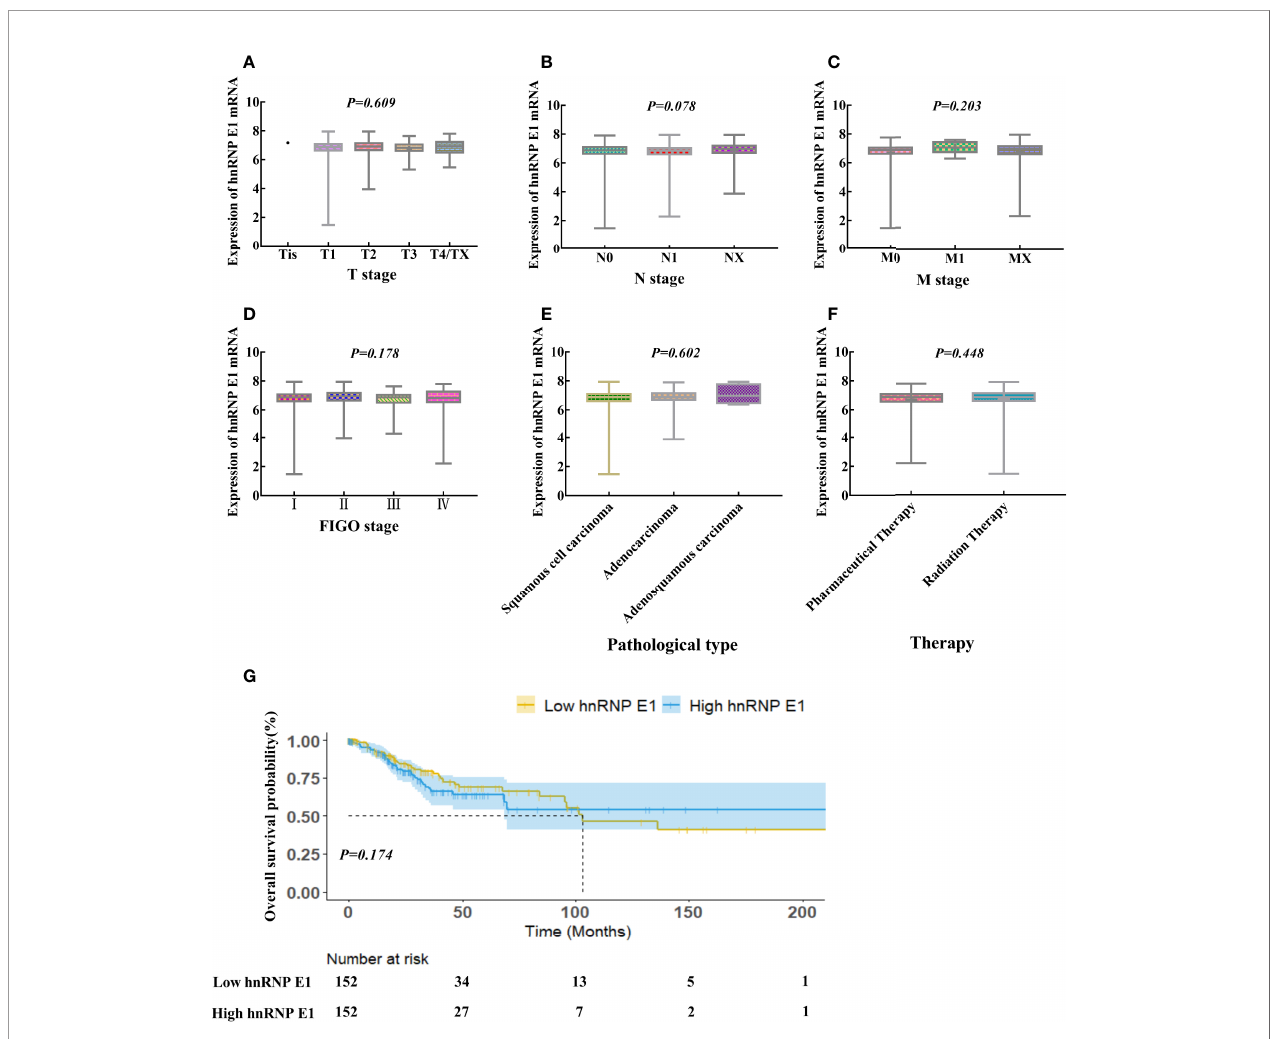
FIGURE 3 | Correlations between hnRNP E1 and prognosis of the patient with cervical cancer based on TCGA database. hnRNP E1 mRNA expression levels in the different T stage (A) , N stage (B) , M stage (C) , International Federation of Gynecology and obstetrics (FIGO) stage (D) , Pathological type (E) and Therapy (F) . (G) Kaplan-Meier survival curves were performed for the overall survival